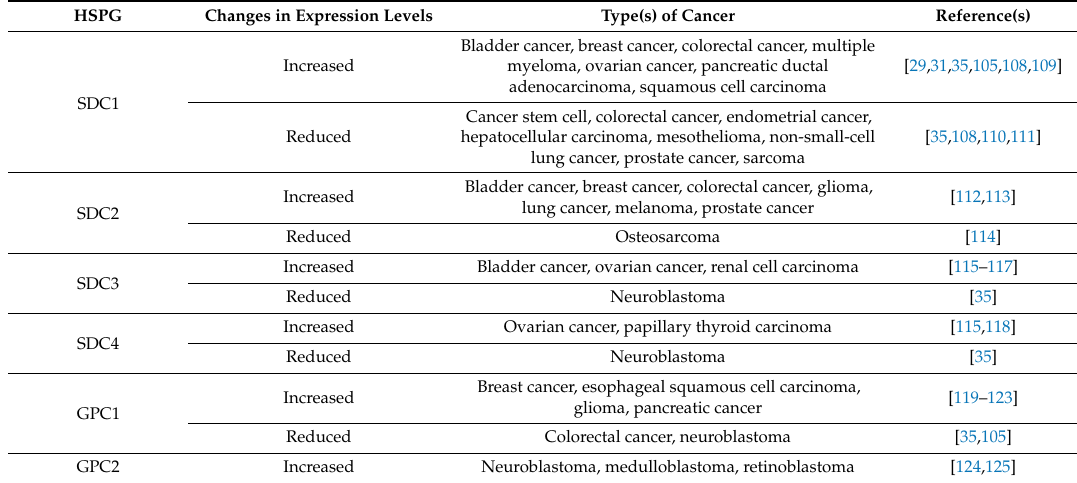
Table 3. Di ff erential expression of individual HSPGs in